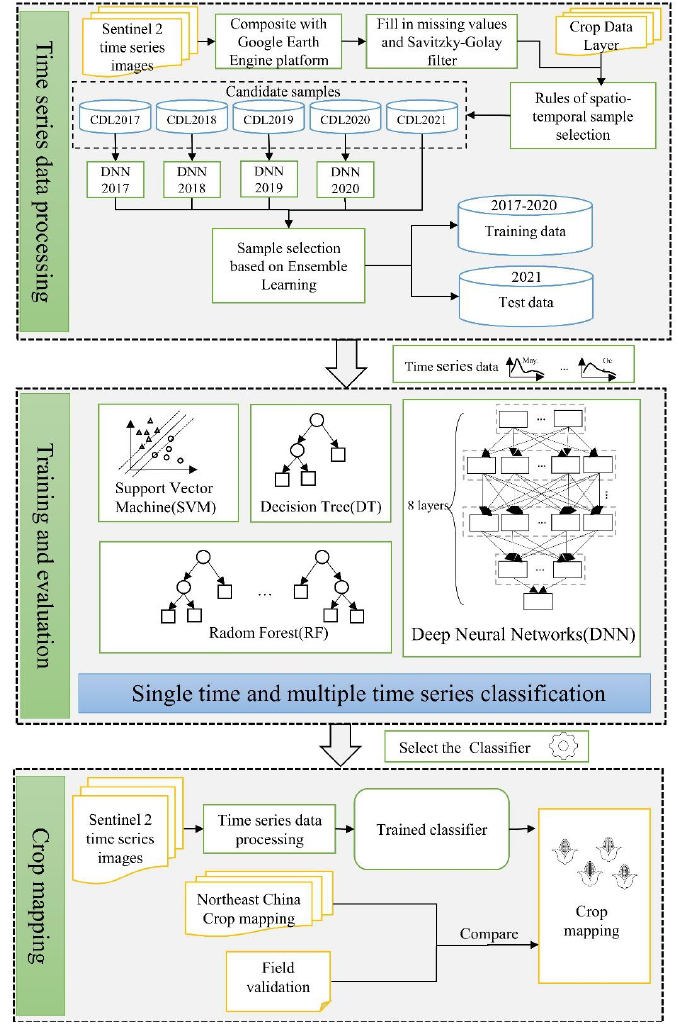
Figure 2. Flowchart for the crop mapping.